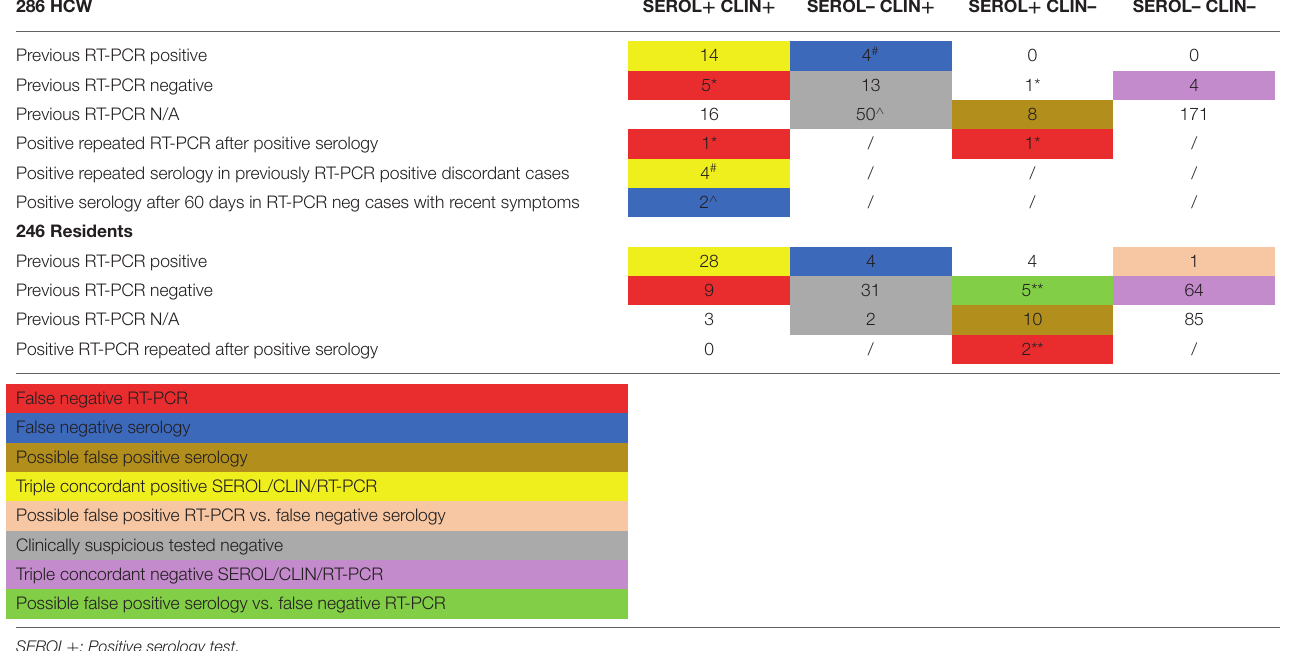
TABLE 4 | Integrated screening interpretation: a case was considered positive for COVID-19 when 2 of 3 parameters where satisfied—a negative serology or RT-PCR test result was considered false negative only if associated with COVID-19 related symptoms or CT imaging and a positive test. 286 HCW SEROL + CLIN + SEROL– CLIN + SEROL + CLIN– SEROL– CLIN– Previous RT-PCR positive 14 4 # 0 0 Previous RT-PCR negative 5* 13 1* 4 Previous RT-PCR N/A 16